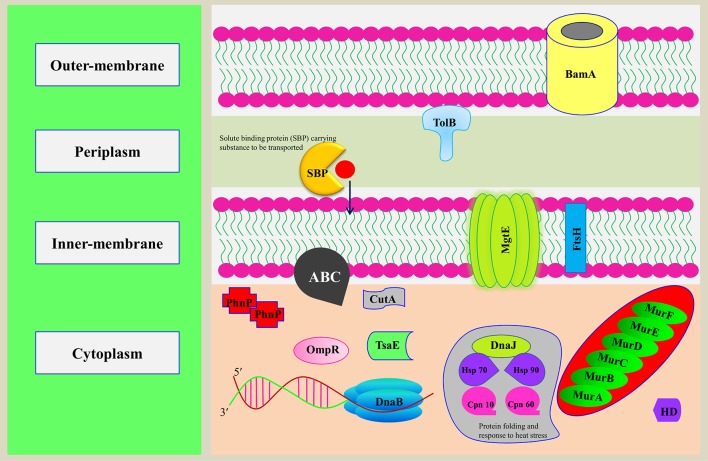
Representation of putative MBPs of Orientia tsutsugamushi in bacterial cell. The functional annotation of MBPs was performed after prediction of domains and family by computational tools. In addition to using computational tools, literature review was also performed to classify putative MBPs. Some of the putative MBPs were shown in the bacterial cell with their probable localization and functions they performed. Proteins from each functionally classified category, i.e., metabolism (MurA, MurB, MurC, MurD, MurE, and MurF), gene expression and regulation (DnaB and BamA), transport (ABC, MgtE, TolB, and SBP), cell signaling (HD and OmpR), antimicrobial resistance [metallo-β-lactamase (PhnP)], posttranslational modification (TsaE), protein folding (Hsp 90, HSP 70, Cpn 10, Cpn 60, and DnaJ), proteolysis (FtsH), and stress response regulator (CutA), were shown. MurA, B, C, and D are the major enzymes involved in the biogenesis of the peptidoglycan. DnaB is involved in the separation of DNA duplex into single strands, and BamA is an integral outer-membrane protein engaged in assembly and insertion of β-barrel proteins into the outer membrane. ABC, MgtE, TolB, and SBP are involved in the transport of ions, nutrients, and toxins. HD domain containing proteins involved in cooperative hydrolysis of c-di-AMP and OmpR act as two-component signal transduction transcriptional regulator. PhnP is metallo-β-lactamase which catalyzes the hydrolysis of all β-lactam antibacterials. TsaE helps in tRNA threonylcarbamoyl adenosine modification. FtsH is an ATP-dependent protease which degrades misfolded membrane proteins. CutA exhibit response to ion tolerance. Hsp 90, HSP 70, Cpn 10, and Cpn 60 stabilize and protect the disassembled polypeptides in response to heat shock conditions and are involved in protein folding. DnaJ regulates the activity of Hsp70.